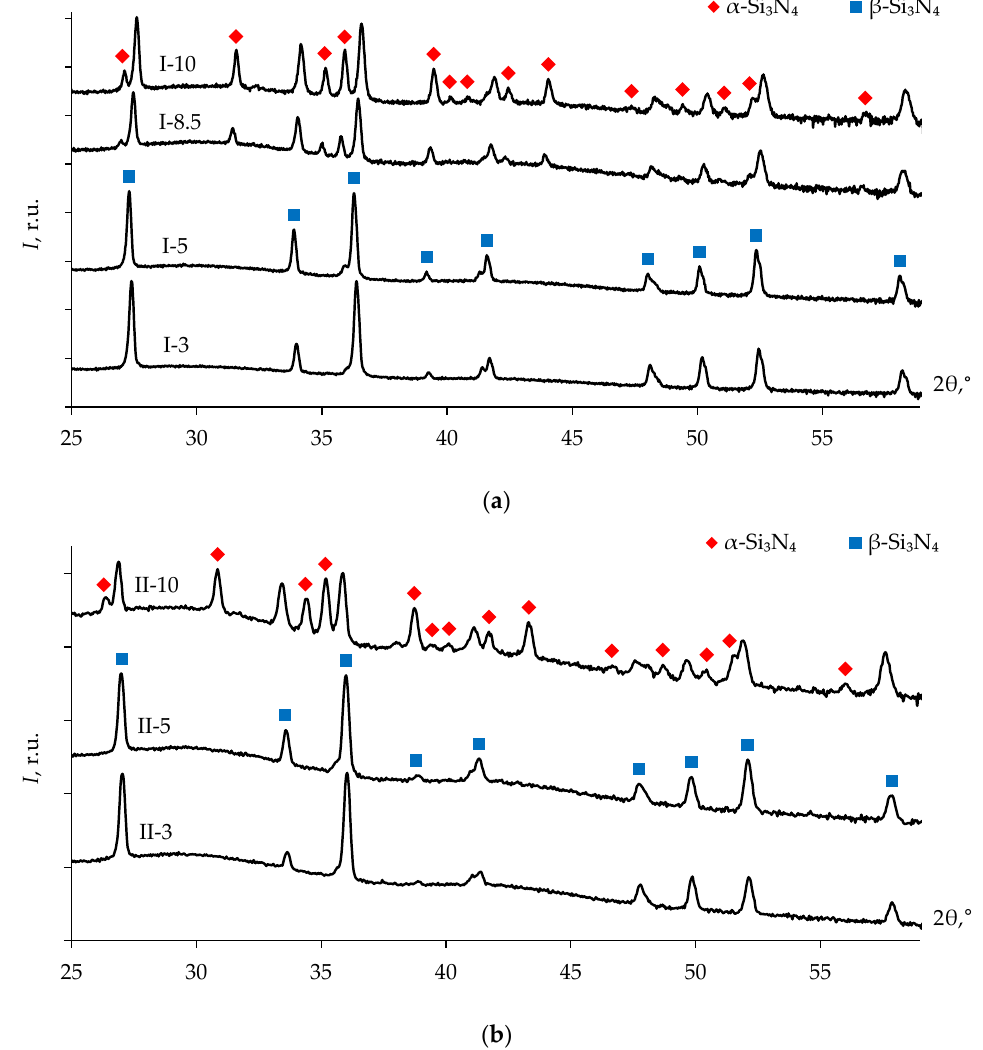
Figure 6. Diffraction patterns from the ceramic samples with different amounts of the sintering additive in the powder mixtures synthesized by method I ( a ) and by method II ( b ).